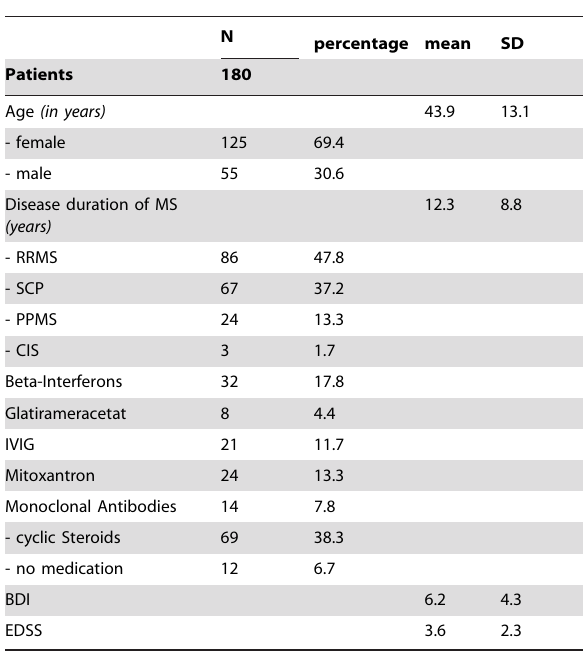
Table 2. Socio-demographic and neurological parameters of MS patients.